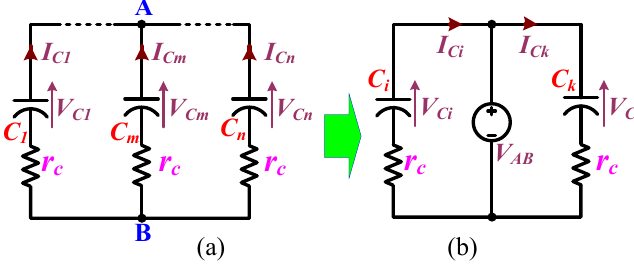
Figure 7. ( a ) Modified state circuit; and ( b ) equivalent circuit for the phase Φ 2 .